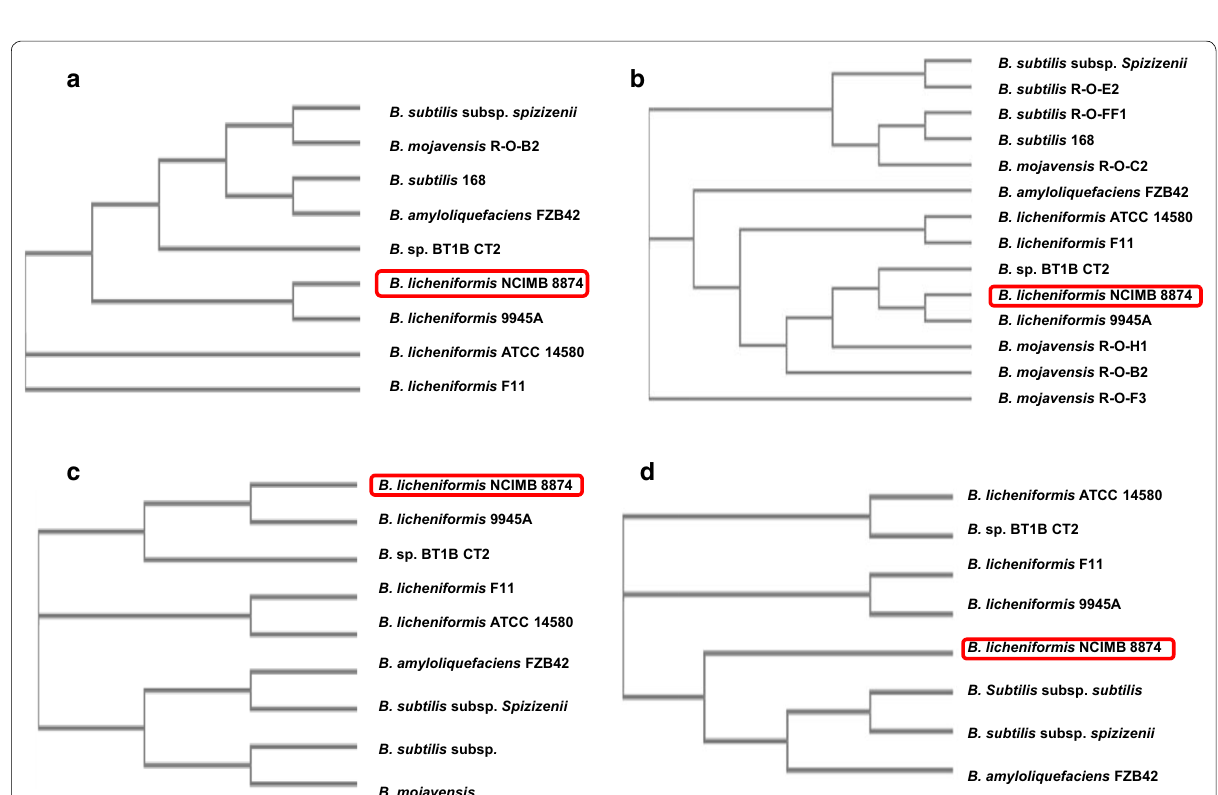
Fig. 2 Phylogenetic tree analysis of the protein sequences of a ComQ, b pre-ComX, c ComP and d ComA using Clustal Omega. The red box denotes B. licheniformis NCIMB 8874. The distance values show the number of substitutions as a proportion of the length of the